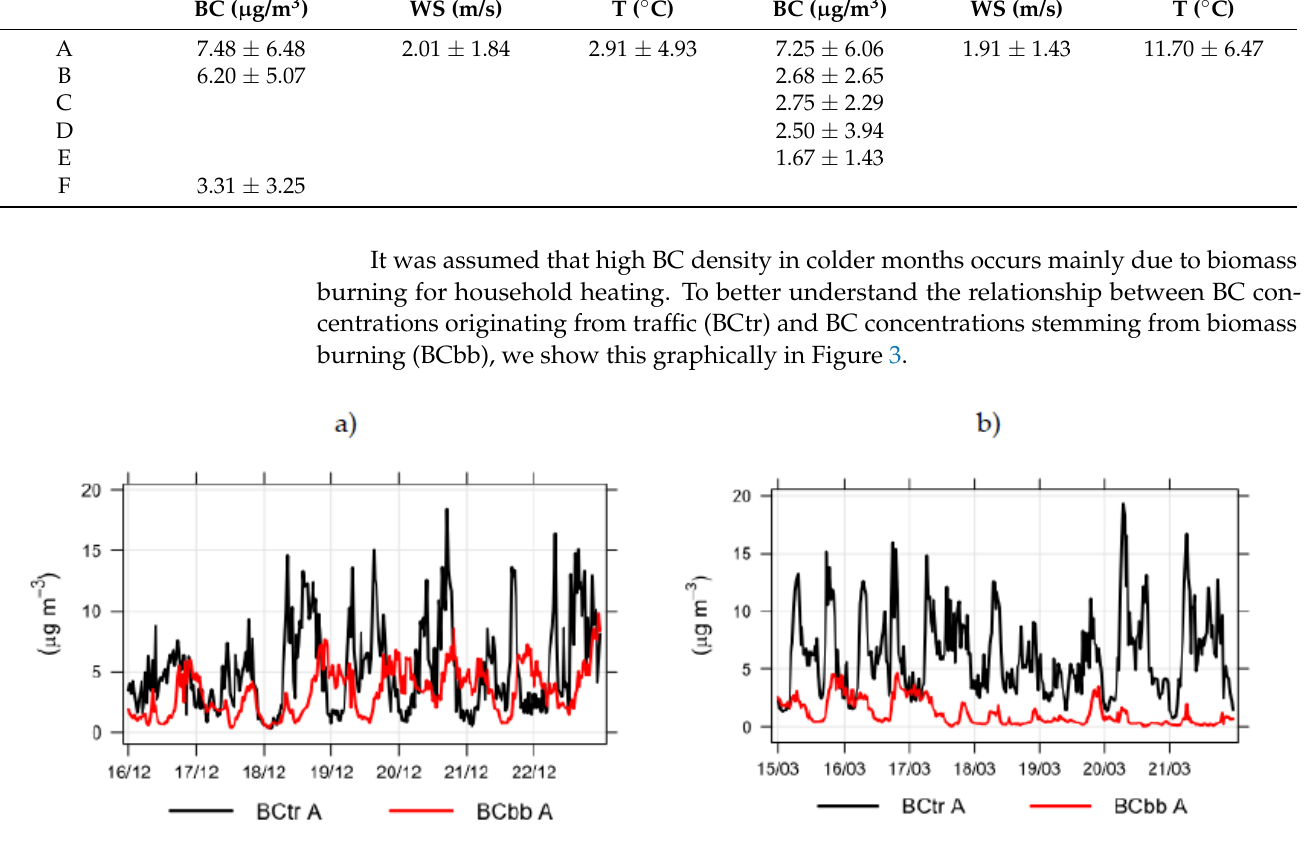
Figure 3. BC concentrations originating from traffic (BCtr) and biomass burning (BCbb) during winter ( a ) and spring ( b ) at measuring point A.